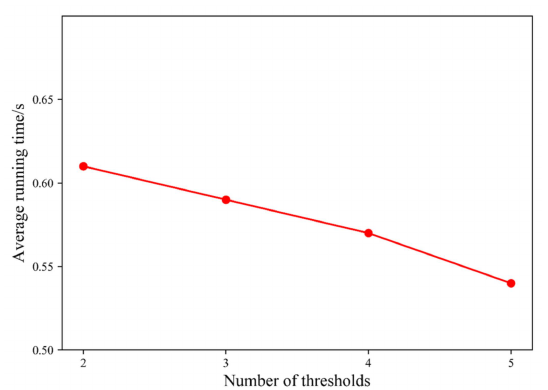
Figure 9. The average running time of the proposed algorithm under different